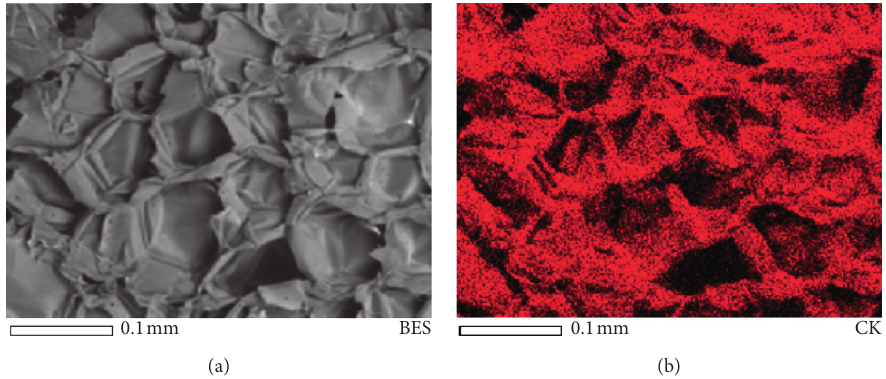
Figure 4: Chemical elements constituting the RVP: (a) carbon and (b) oxygen.